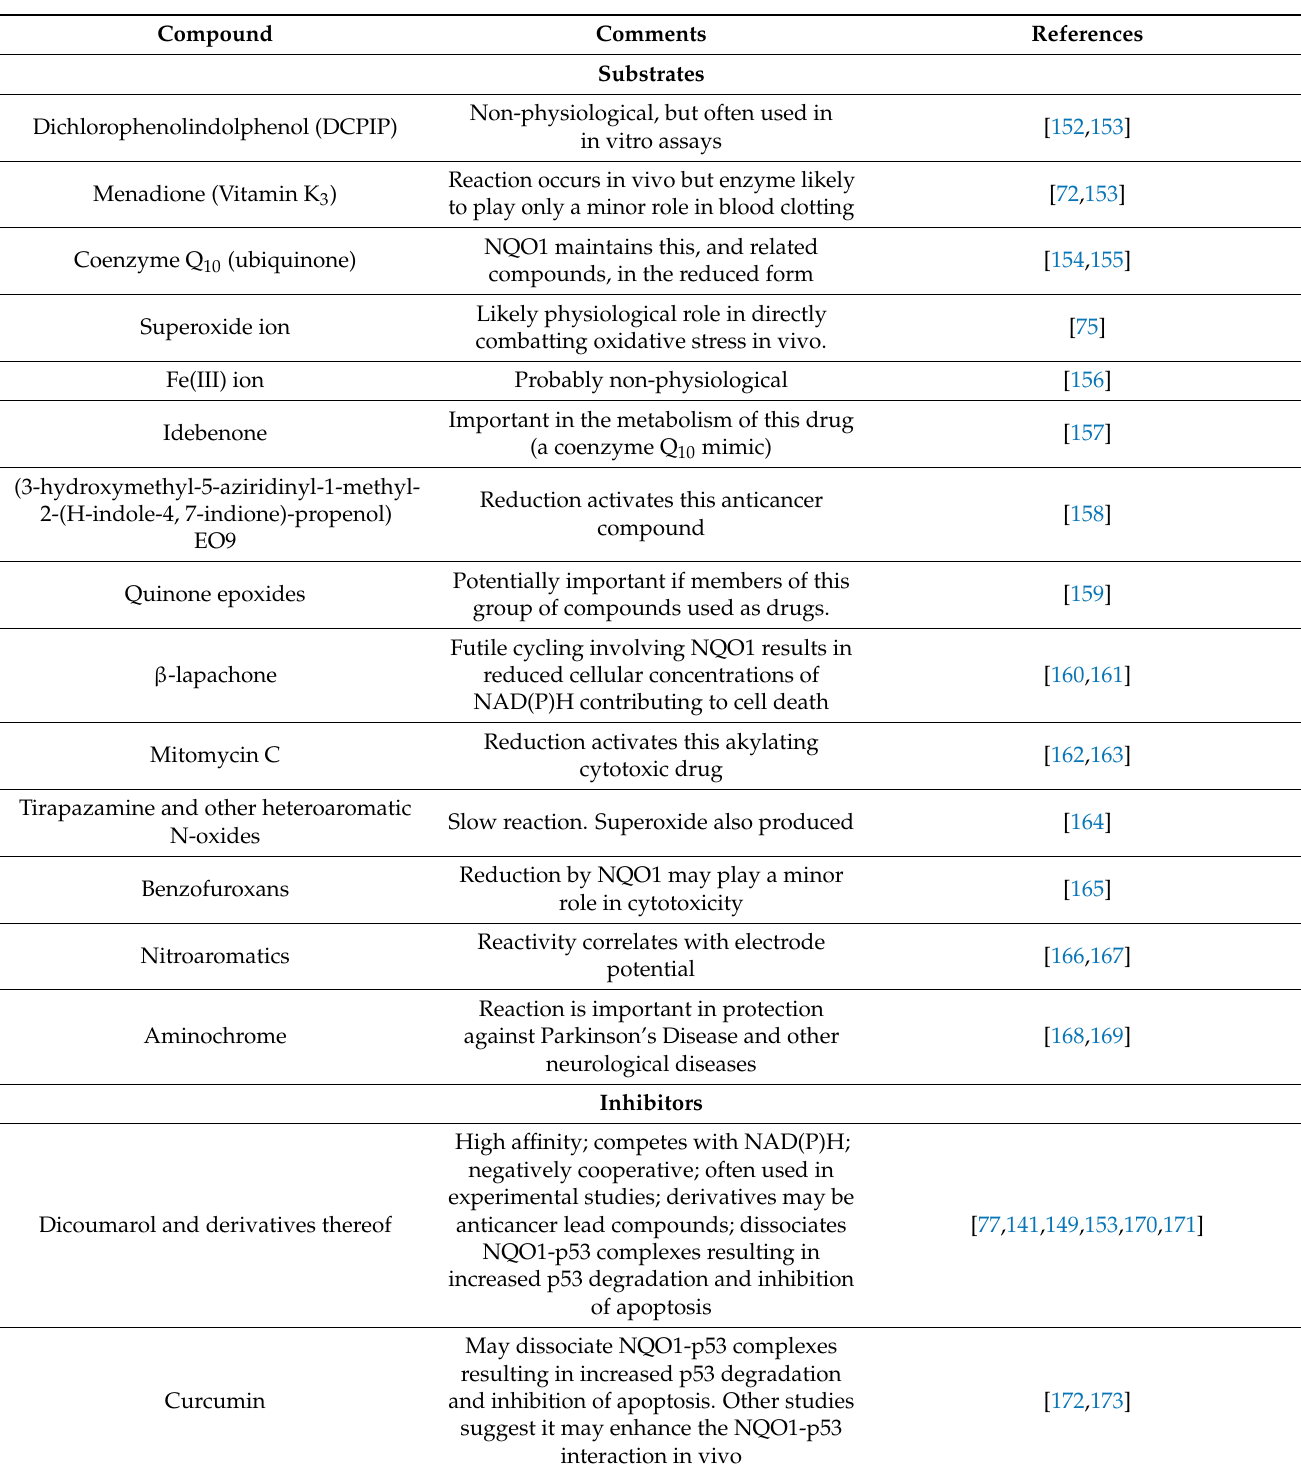
Table A1. Selected substrates and inhibitors of